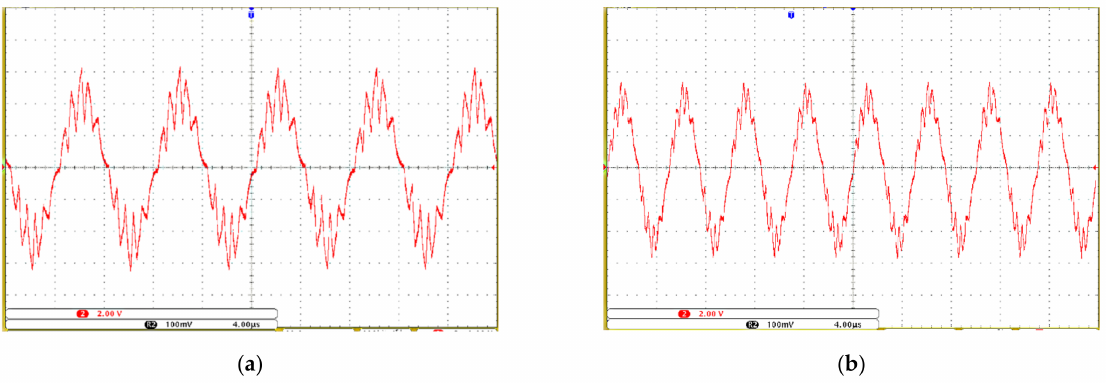
Figure 15. Comparison waveforms of current by regulating frequency: ( a ) before regulating, ( b ) after regulating.